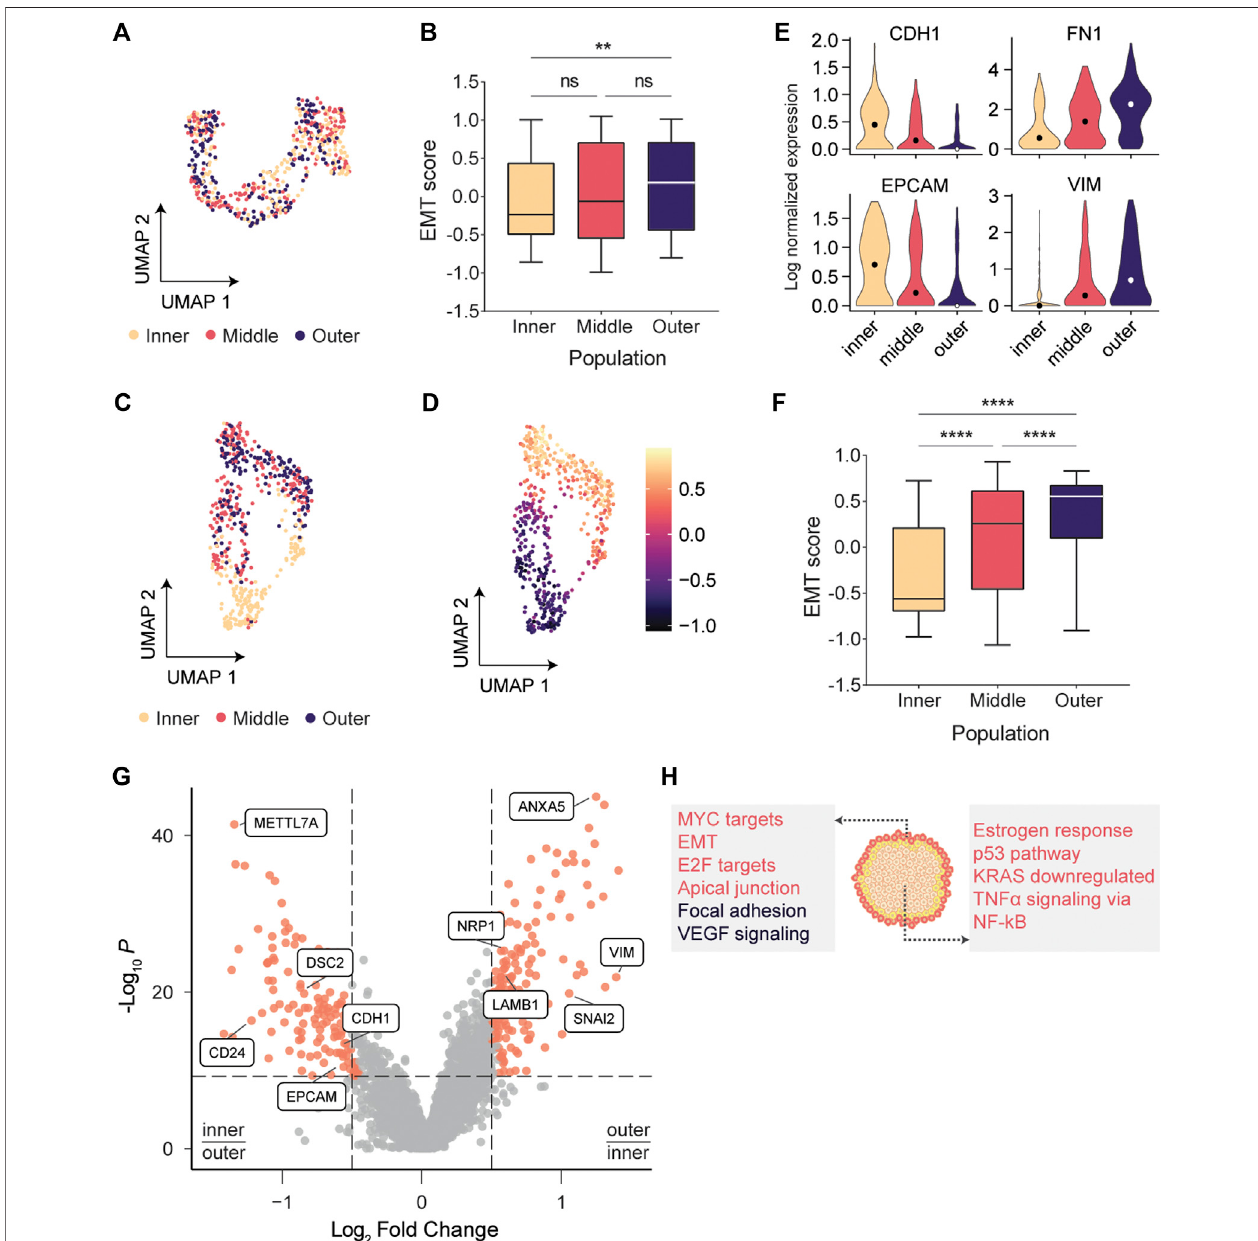
FIGURE 2 | scRNA-seq indicated that cells at the invasive edge were progressing through EMT. (A) UMAP embedding of cells labeled with the larger bandwidth showedamodestseparationoftumor regions,but nocoherent clusterswereformed. (B) EMTscoresbetweeninner and outerpopulationsvarysigni fi cantly( p =.0017; Kruskal-Wallis test). (C) Inner and outermost tumor regions labeled with the smaller bandwidth separate clearly in UMAP space. (D) EMT scores gradually increase across the UMAP embedding. (E) Expression of classic epithelial markers decreases radially outwards while expression of classic mesenchymal markers increases. (F) EMTscoresaresigni fi cantlyvaryingbetweenadjacent populations ( p < .0001;Kruskal-Wallistest). (G) Volcano plotindicatinggenesoverexpressedinthe outermost population (log 2 (FC) > .5) and in the inner population (log 2 (FC) < − .5). (H) Overrepresentation analysis using the MSigDB Hallmarks (red) and Wikipathways (black)